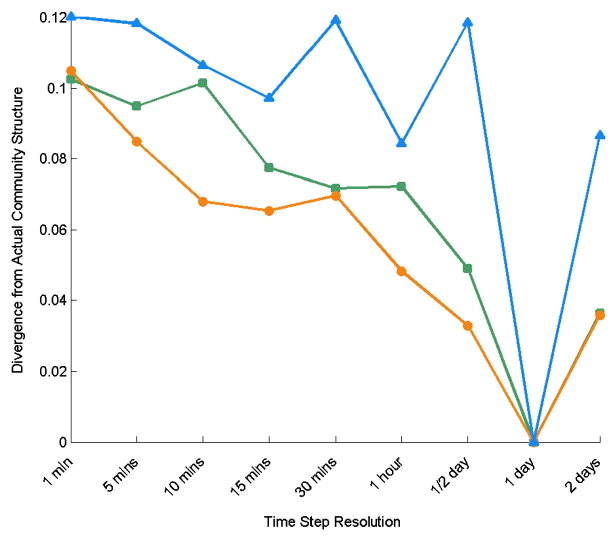
FIG. 14. Multifrequency analysis of the variation of informa- tion between each of the nine data sets of different time resolutions and the partition for the data set of daily time steps. It can be seen that all data sets yield partitions quite similar to each other, but there is still slight degradation as the resolution gets finer. (The Potts algorithm is shown by green squares, the Louvain algorithm by orange circles, and the spectral algorithm by blue